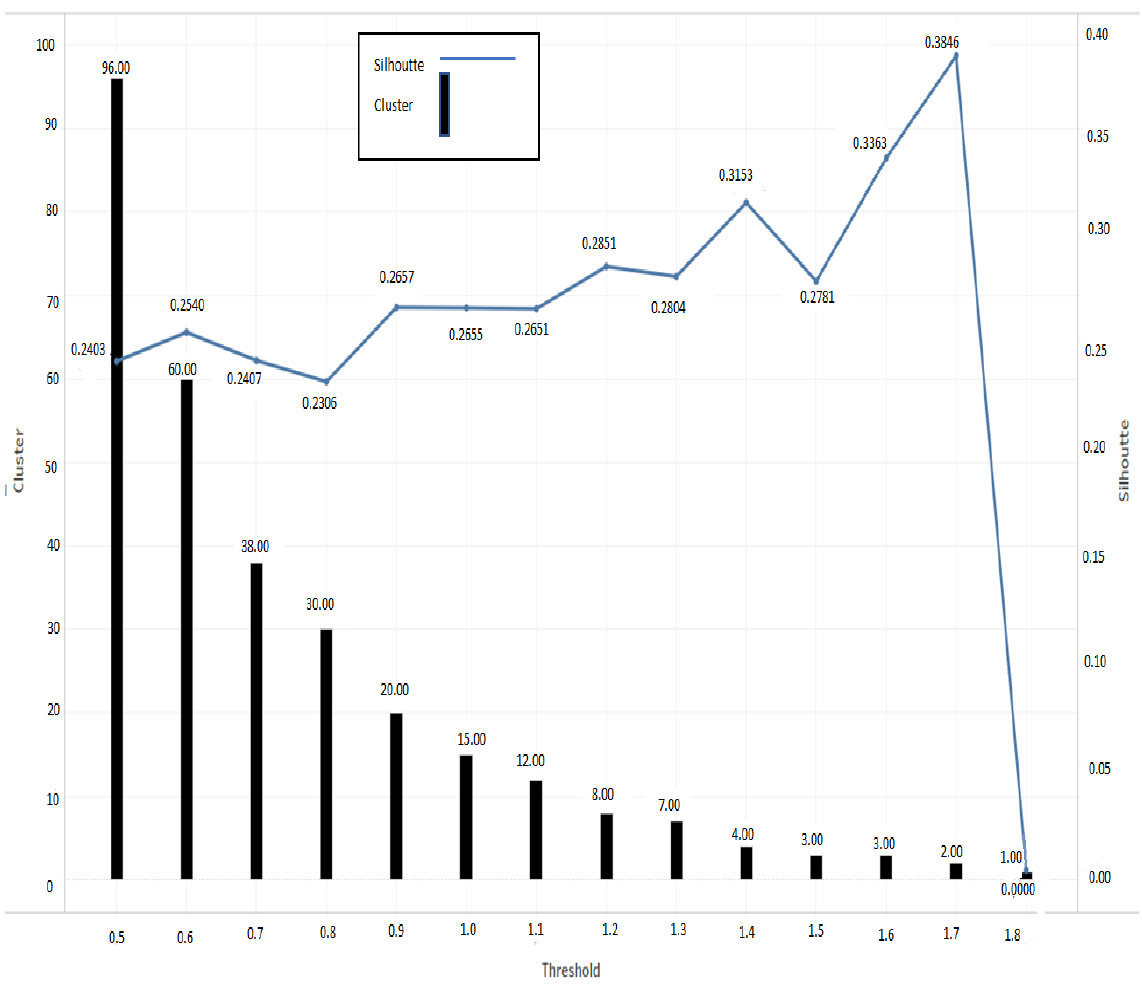
Figure 4. Cluster evaluation corresponding to different threshold.